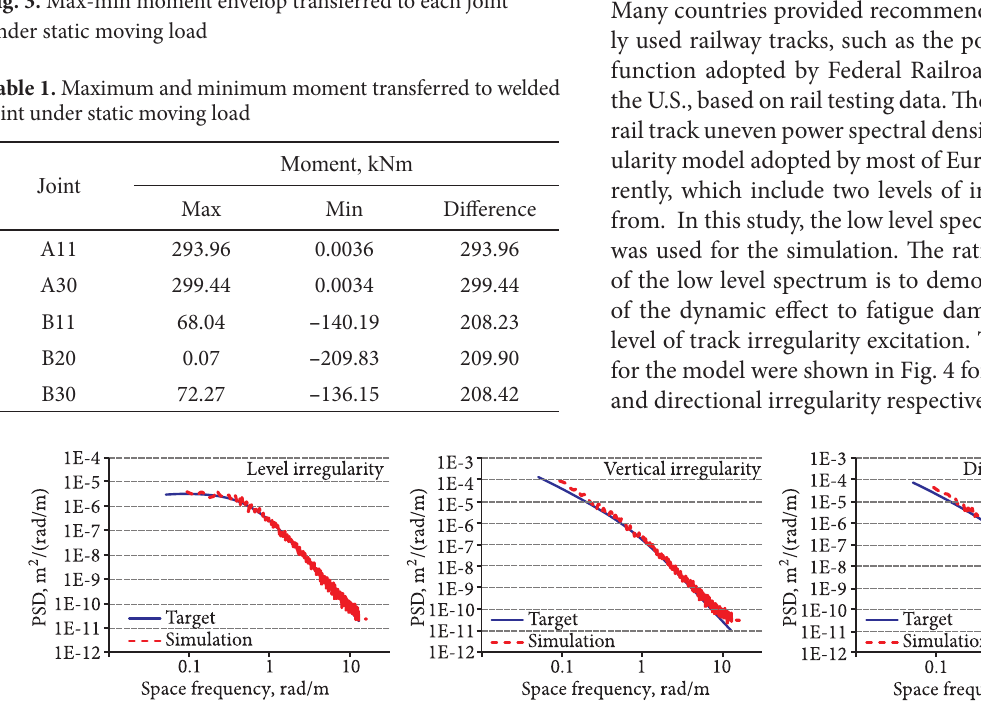
Fig. 4. Power spectrum density function for rail irregularity (German low level